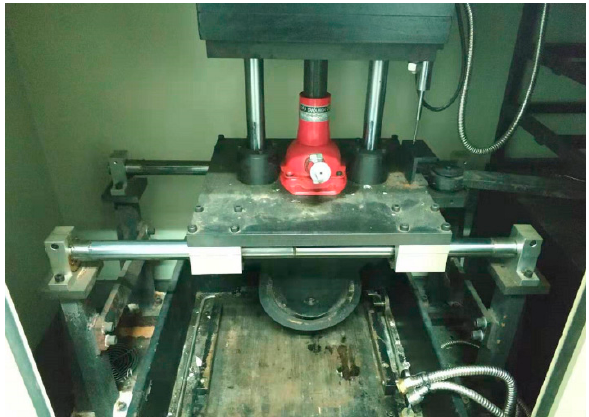
Figure 4. Wheel tracking tests instrument.